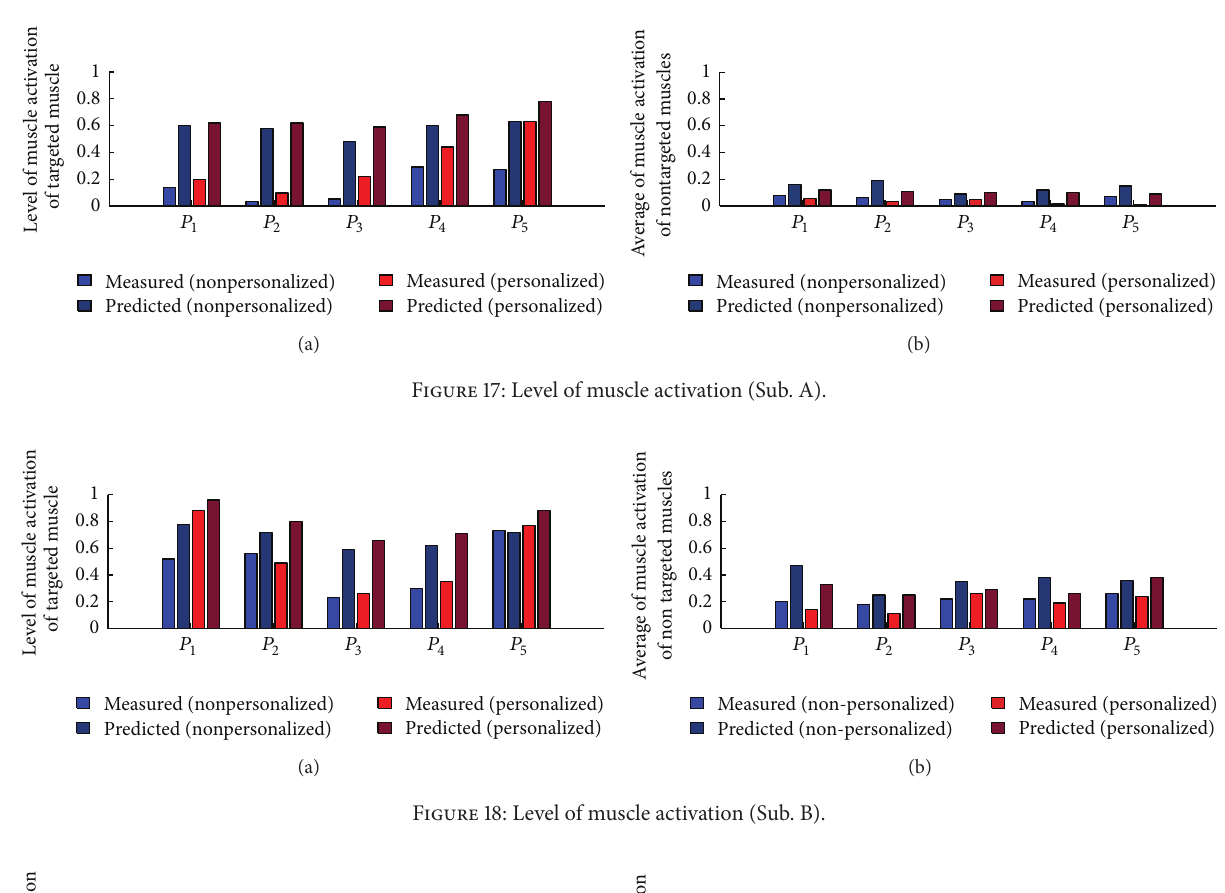
Figure 18: Level of muscle activation (Sub. B).